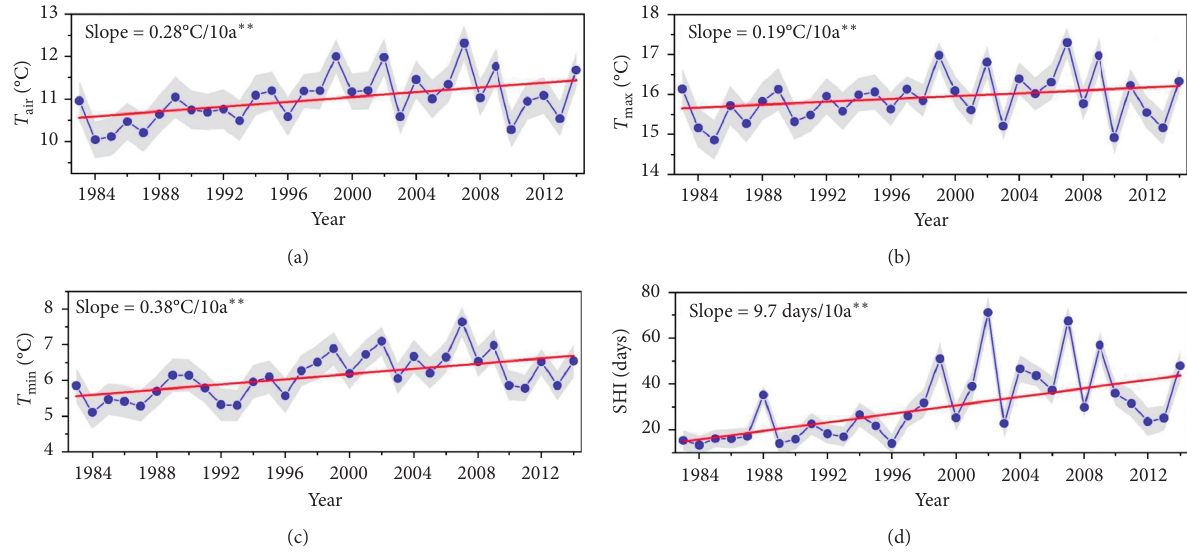
Figure 2: The linear trends of annual average. (a) T